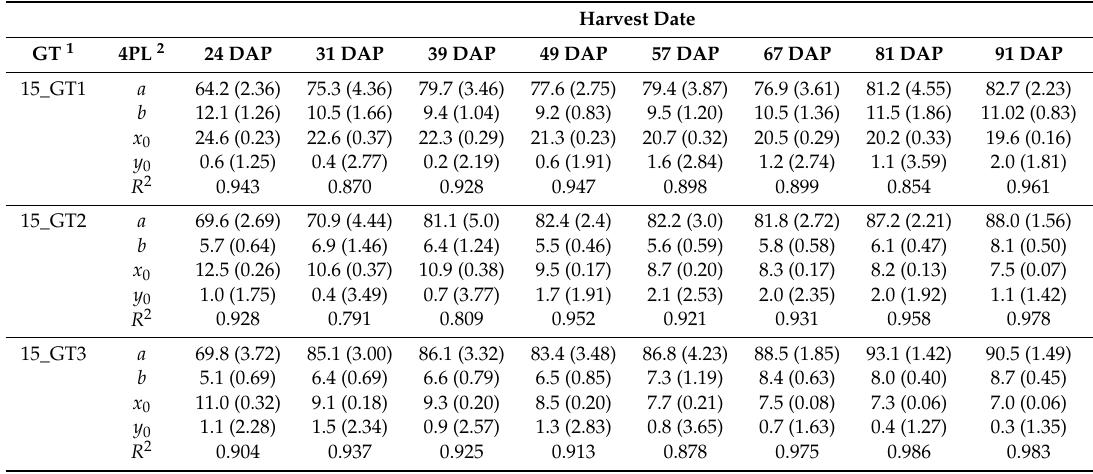
indicates the lower percentage germination limit. Table 2. Four-parameter logistic (4PL) regression parameter estimates for percentage germination in response to the number of days after imbibition for seeds harvested in 2017 across eight different harvest dates numbered by days after pollination (DAP). Standard errors are shown in parentheses.